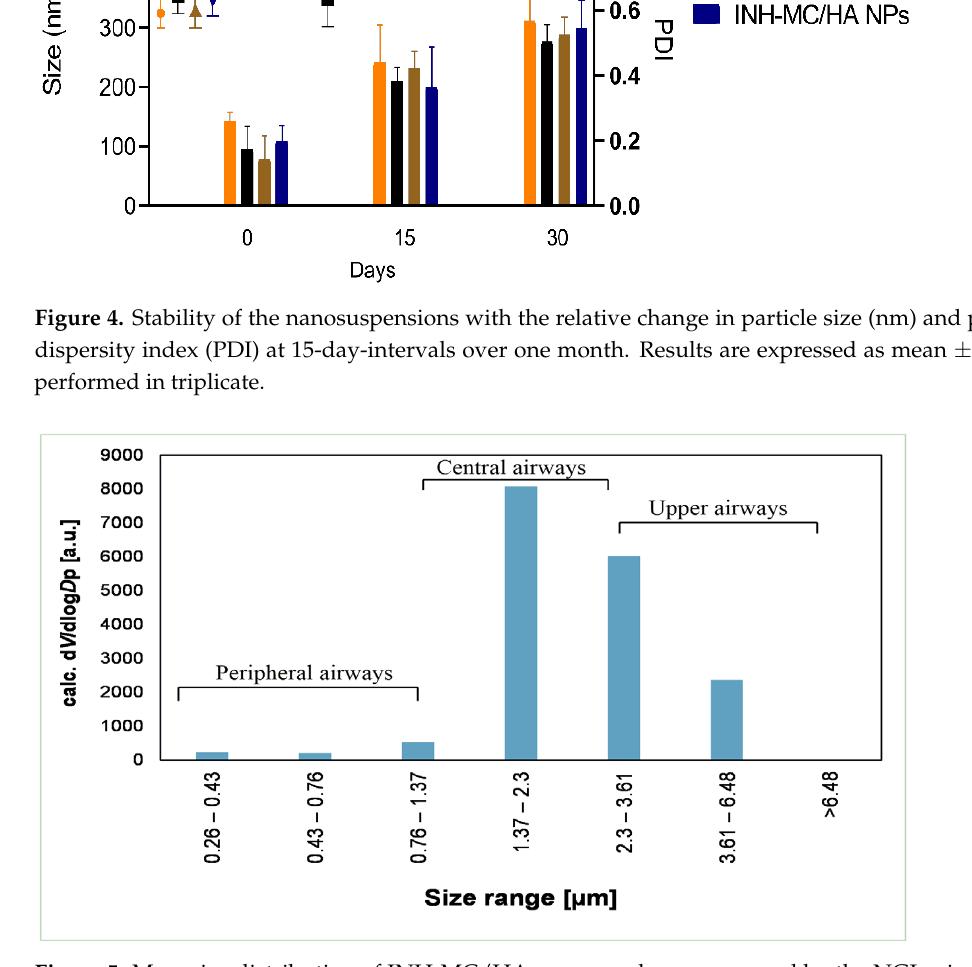
Figure 5. Mass size distribution of INH-MC/HA nanopowder as measured by the NGI using the data evaluation method based on the surface coverage of the collection plates.